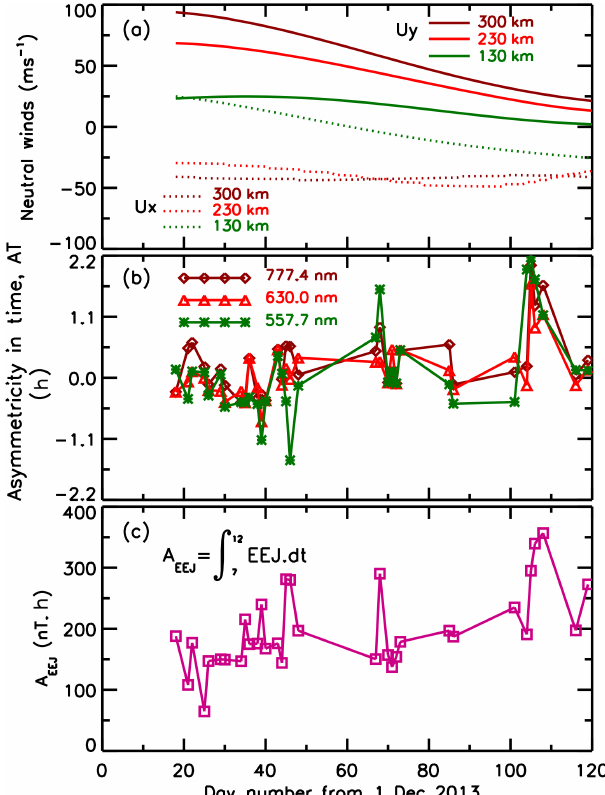
Figure 5. The variation in (a) neutral winds at the three different emission altitudes, (b) the asymmetricity in time (AT) at the three dayglow emission intensities on different days, and (c) EEJ strength integrated over 07:00–12:00LT ( A EEJ ) on the days corresponding to optical data are shown. The x axis shows the day number starting from 1 December